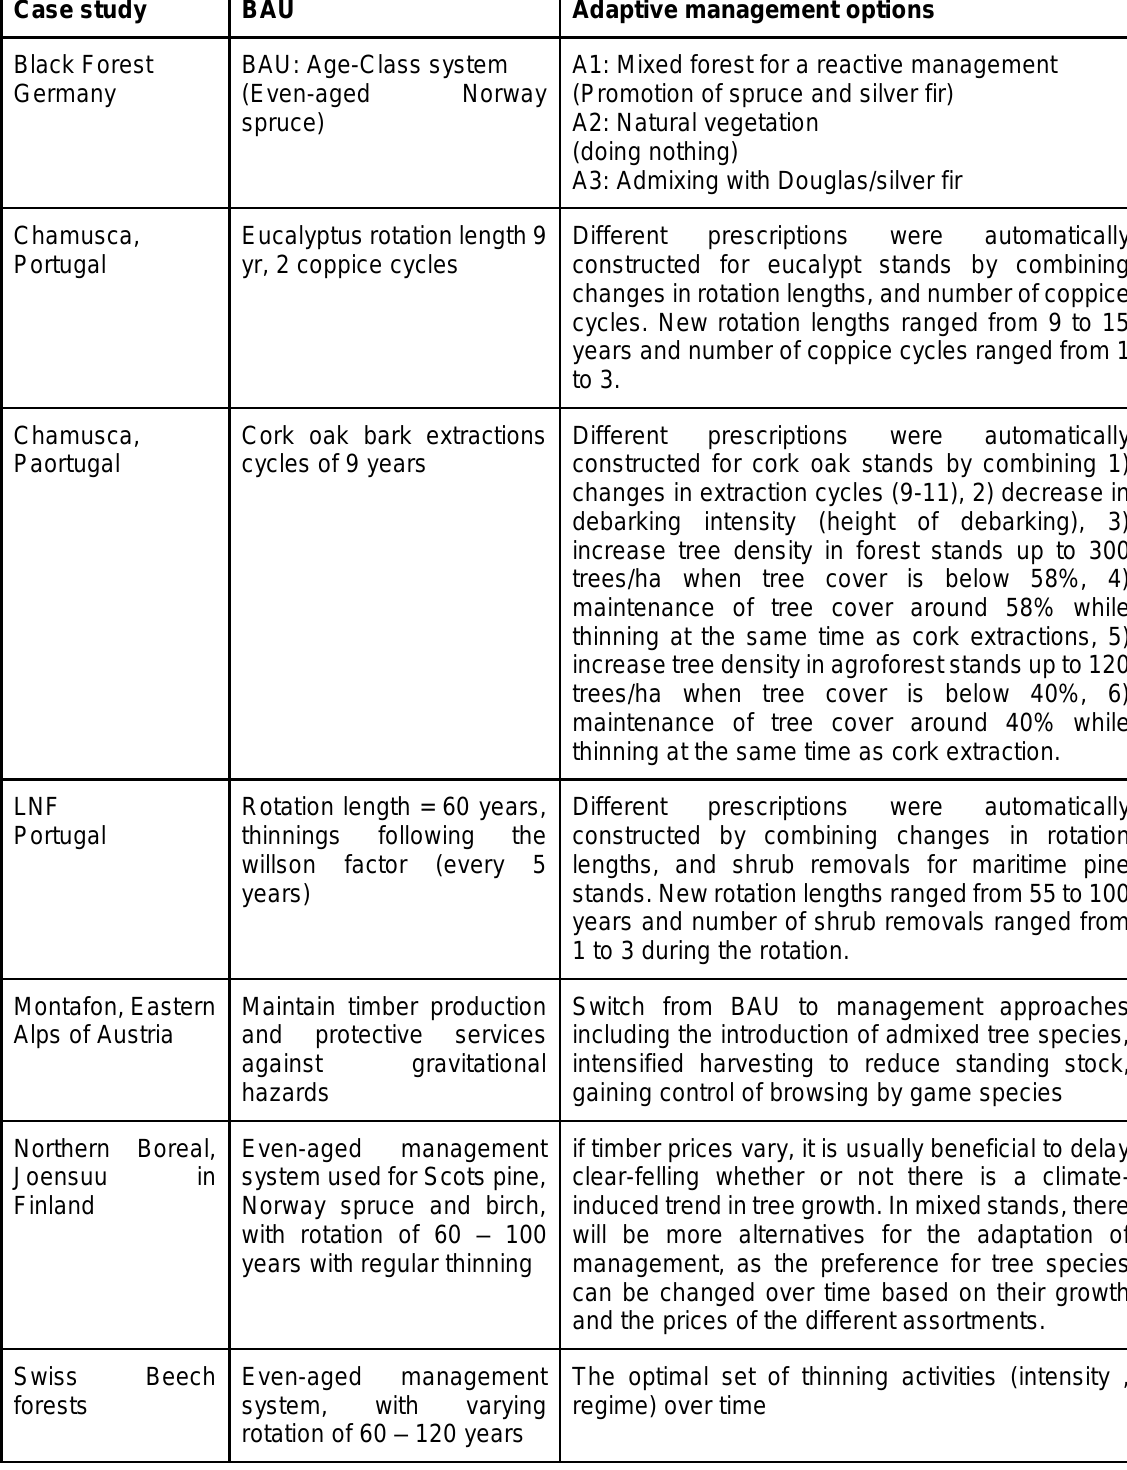
Table A3.1 Summary of case studies’ management strategies including BAU (Business